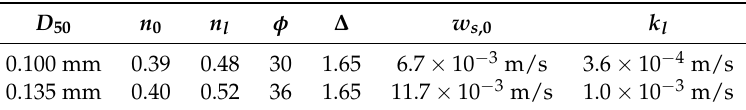
Table 1. Sand parameters used in the calculations of the erosion